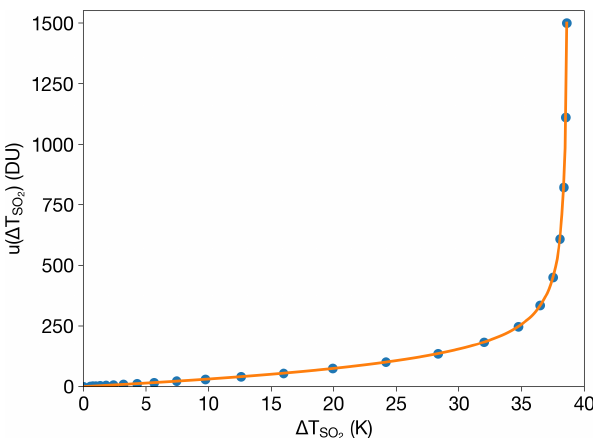
Figure B4. MODTRAN-6.0 simulation results used to derive SO 2 total column density as a function of brightness temperature difference (see Eq. B1) for a uniform distribution with cloud-top height of 13.5km and thickness of